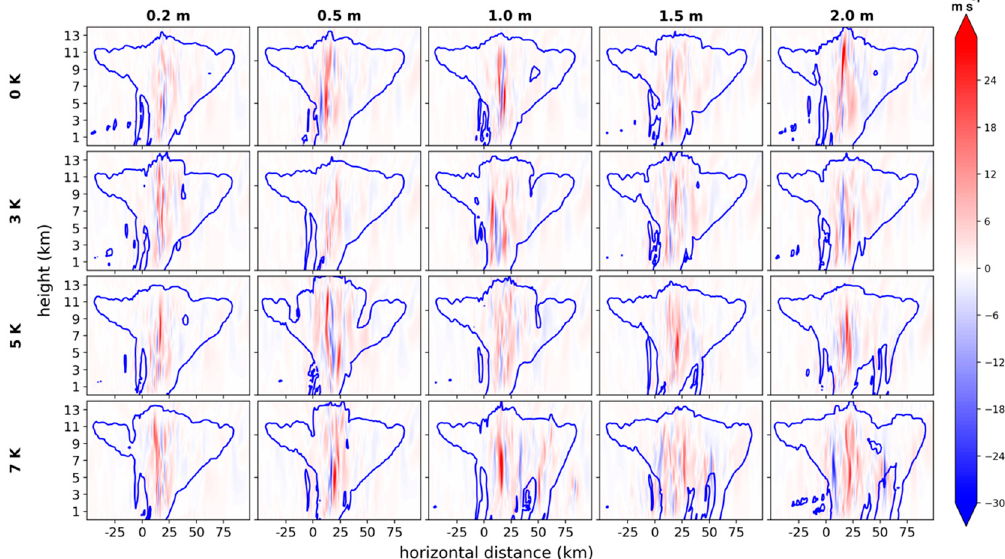
Figure 7. Change in vertical velocity between t = 130 min and t = 170 min (colored) in each simulation. The blue contour represents the hydrometeor mixing ratio of 0.02 g kg − 1 at t = 170 min. The colored field was calculated by subtracting the vertical velocity field at t = 170 min from the same field at t = 130 min after adjusting for a storm motion in the earlier field using the mean environmental winds.